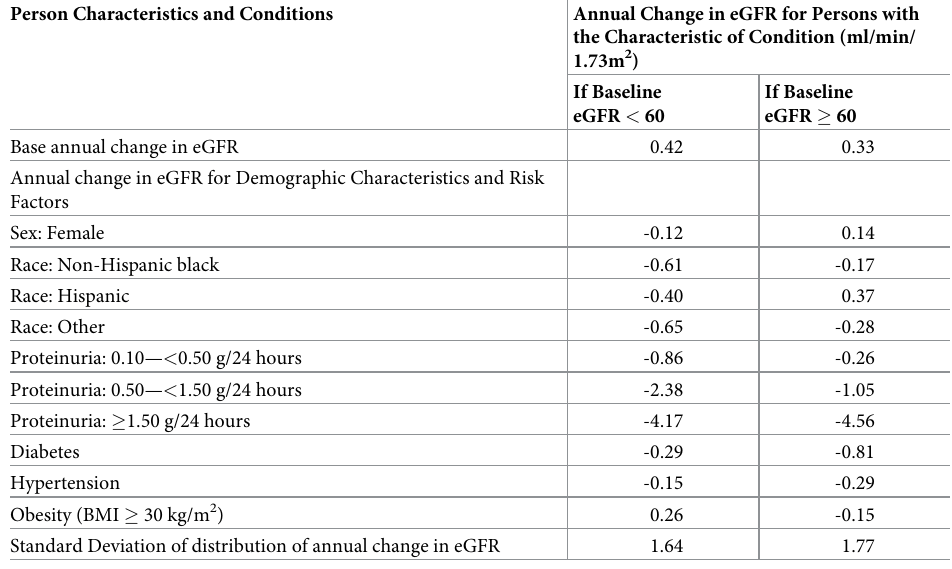
Table 2. Model parameters for annual change in eGFR based on person characteristics and conditions and base- line eGFR. Person Characteristics and